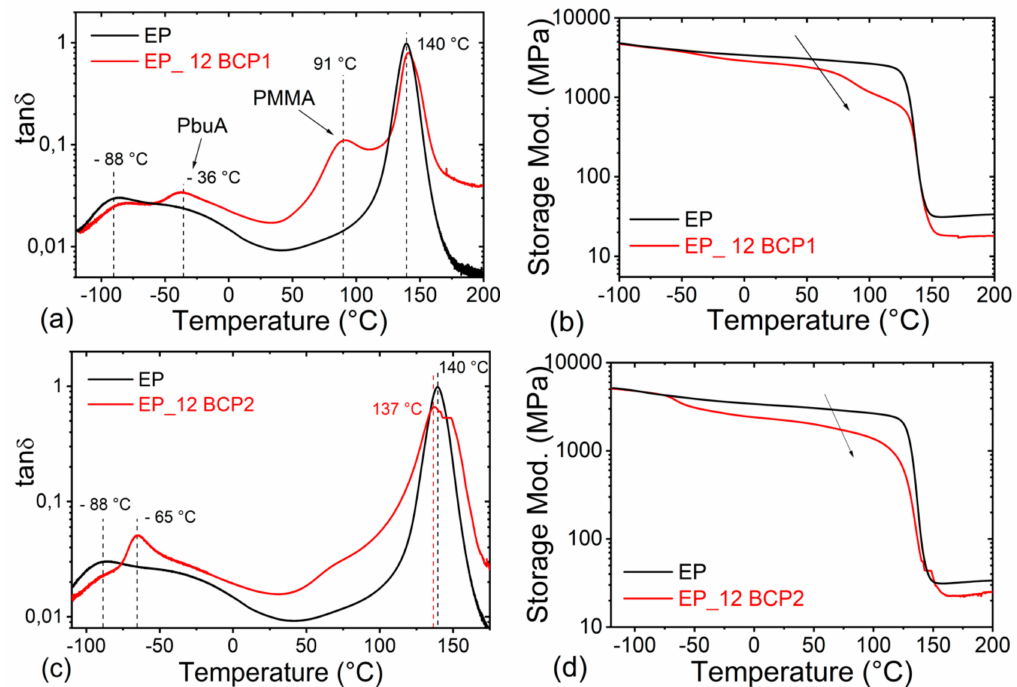
Figure 1. Graph showing ( a ) tan δ and ( b ) storage modulus, with respect to temperature for the EP_BCP1 systems. ( c ) tan δ and ( d ) storage modulus, with respect to temperature for the EP_BCP2